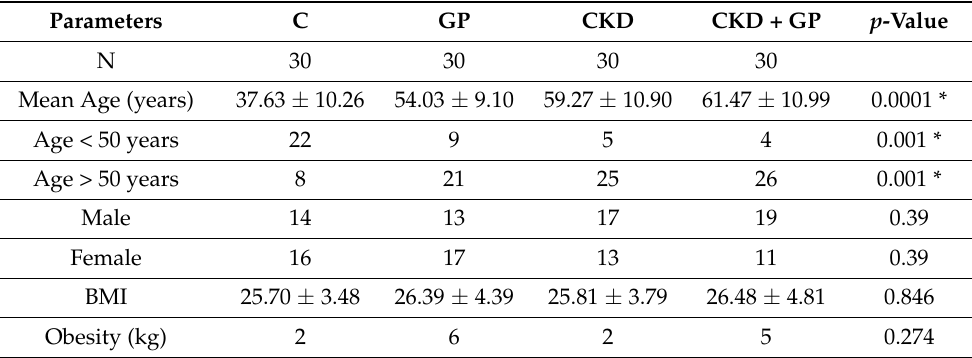
Table 2. Intergroup comparison of the demographic parameters assessed among C, GP, CKD, and CKD + GP